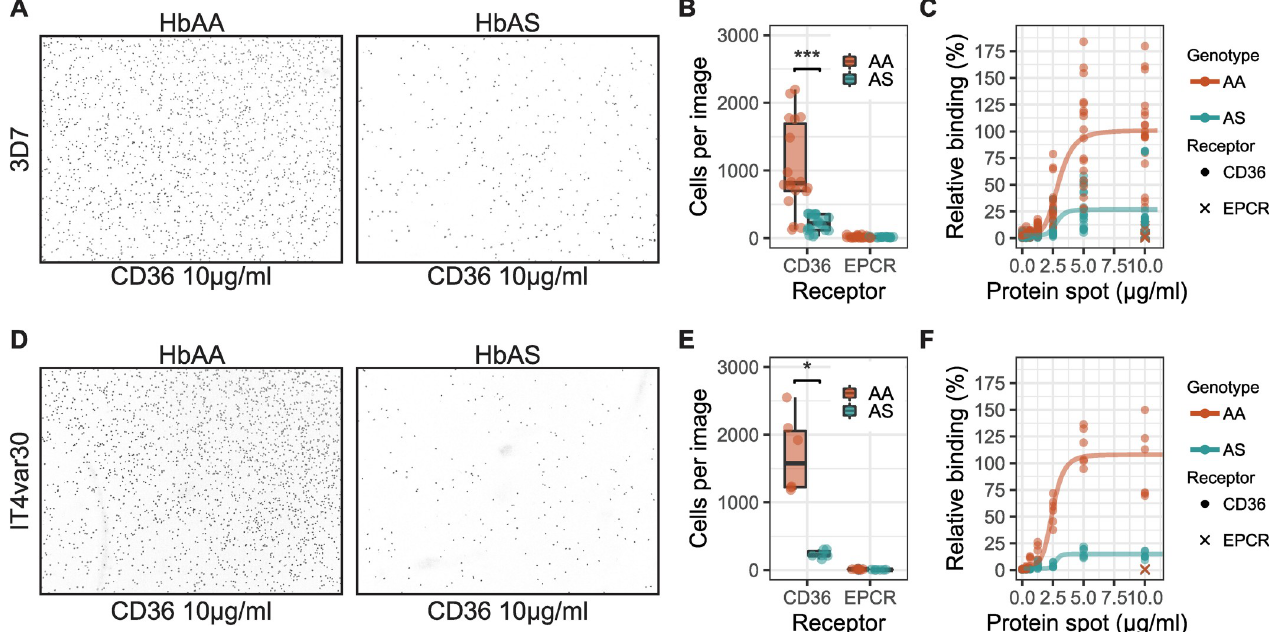
Fig 2. Sickle-cell traits effect on parasite adhesion to CD36. A) HbAA or HbAS RBCs infected with 3D7 reference parasite strain adhering to spots of recombinant CD36 on a petri-dish. B) Quantification of the adhesion of 3D7-infected HbAA and HbAS erythrocytes to 10 μ g/ml CD36 and EPCR spots. Each condition was done as 2 protein spots on separate petri-dishes, each imaged 3 times. The assay was done 3 independent times (n = 3). Wilcoxon’s signed rank test was used to evaluate statistical significance ( ��� p-value = 0.0001). C) Relative adhesion across protein spots of different concentrations normalized to the mean adhesion to CD36 at 10 μ g/ml. Four parameter logistic curve was fitted to the normalized data for HbAA and HbAS. D) HbAA or HbAS RBCs infected with IT4 strain parasites expressing IT4var30-PfEMP1 (IT4var30) adhering to spots of recombinant CD36 on a petri-dish. E) Quantification of the adhesion of It4var30-infected HbAA and HbAS erythrocytes to 10 μ g/ml CD36 and EPCR spots. Each condition was done as 2 protein spots on separate petri-dishes, each imaged 3 times. Wilcoxon’s signed rank test was used to evaluate statistical significance ( � p-value = 0.03). F) Relative adhesion across protein spots of different concentrations normalized to the mean adhesion to CD36 at 10 μ g/ml. Four parameter logistic curve was fitted to the normalized data for HbAA and HbAS (n =